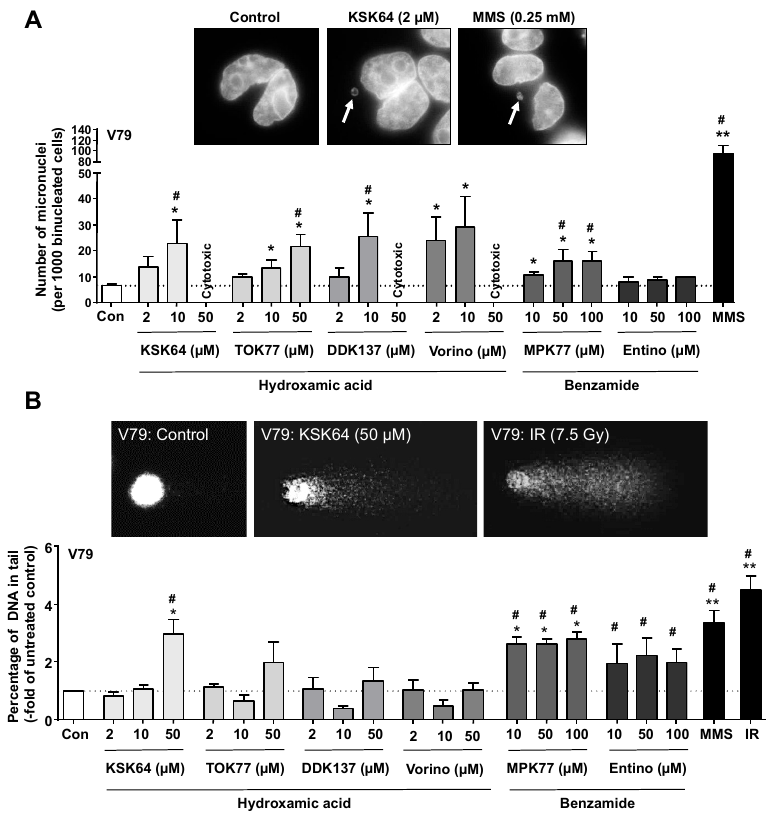
Figure 2. Genotoxic e ff ects of hydroxamic acid- and benzamide-type HDACi as analyzed on the levels of micronuclei and DNA strand break formation. The formation of micronuclei (A) and DNA strand breaks (B) was analyzed after a 24-h treatment period of non-malignant V79 cells with representative HDACi candidate compounds. ( A ) The frequency of micronuclei was analyzed as described in Methods. Shown are representative pictures (the arrows point to micronuclei). Quantitative data (mean ± SEM) presented in the histogram were obtained from three independent experiments (n = 3) with each 1000 cells being analyzed per experiment; *, p ≤ 0.05; **, p ≤ 0.01 as compared to untreated control (Student’s t -test); # ≤ 0.1 (one-way ANOVA with Dunnett’s post hoc test). Data obtained from the use of 100 µ M entinostat were obtained from a single experiment only (therefore, only the mean is shown and this data were excluded from statistical analyses). ( B ) DNA strand break formation was analyzed by the alkaline comet assay as described in methods. In the upper part, representative pictures are shown. Quantitative data presented in the histogram are the mean ± SEM (standard error of the mean) from three independent experiments (n = 3) with each 50 cells being analyzed per experiment; *, p ≤ 0.05; **, p ≤ 0.01 as compared to untreated control (Student’s t -test); # ≤ 0.05 (one-way ANOVA with Dunnett’s post hoc test). See also Supplementary Table S2 (% DNA in tail).